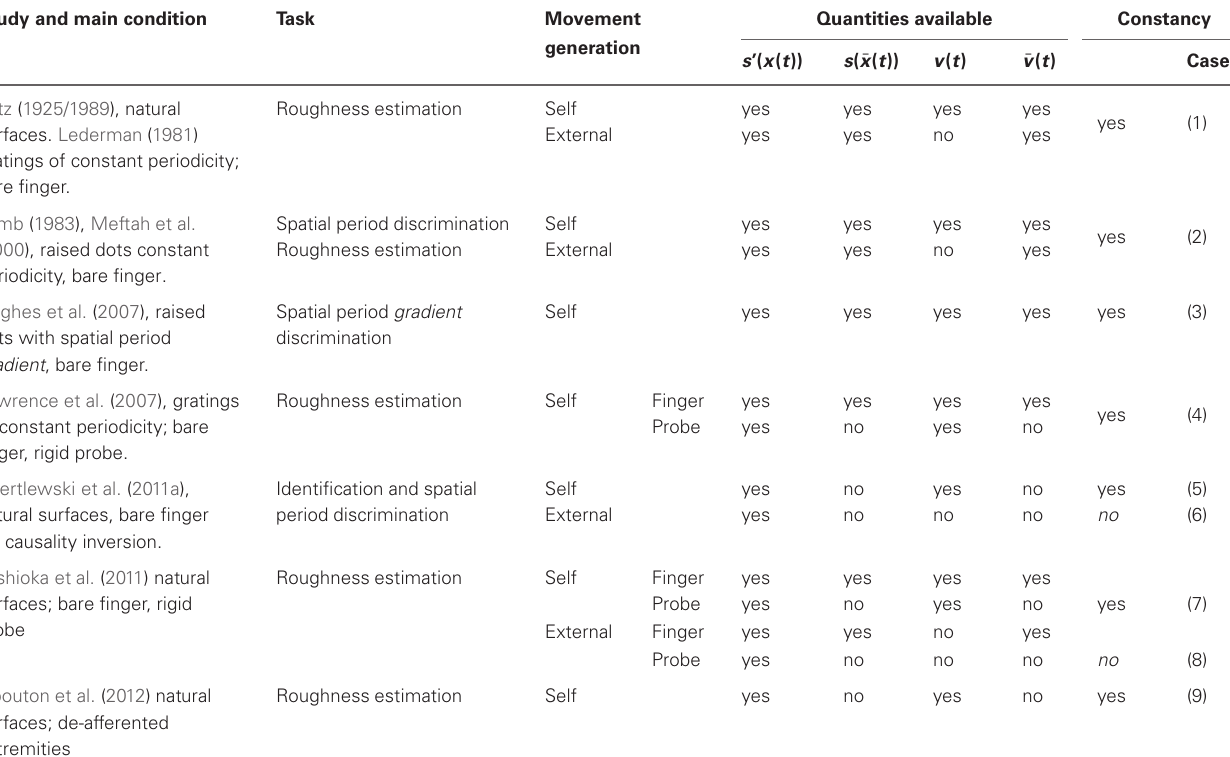
Table 1 | Tabulation of previous results relating to texture constancy which are all explained by the brain’s ability to access specific attributes of the invariant surface descriptor s ( x ) through the temporal gradient s (cid:2) ( ¯ x ) v ( t ) .